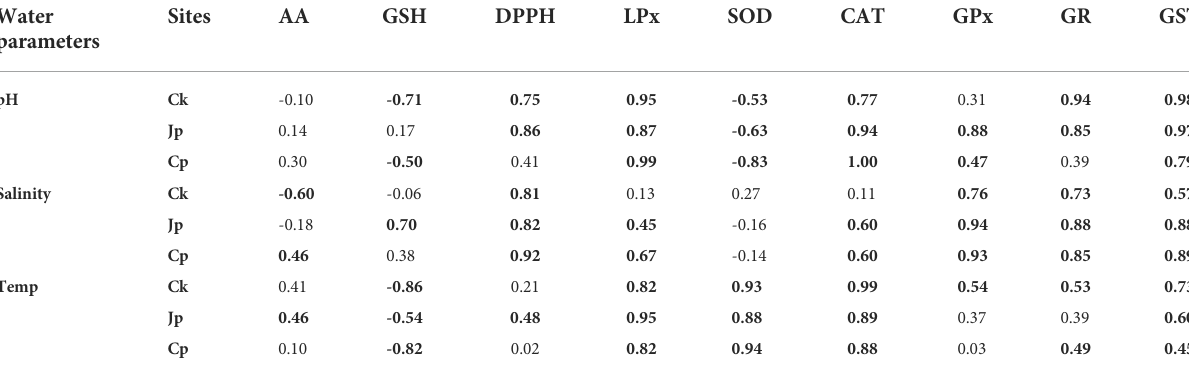
TABLE 2 Correlation analyses between redox regulatory/oxidative stress indices and hydrological factors of the studied sites. Water parameters